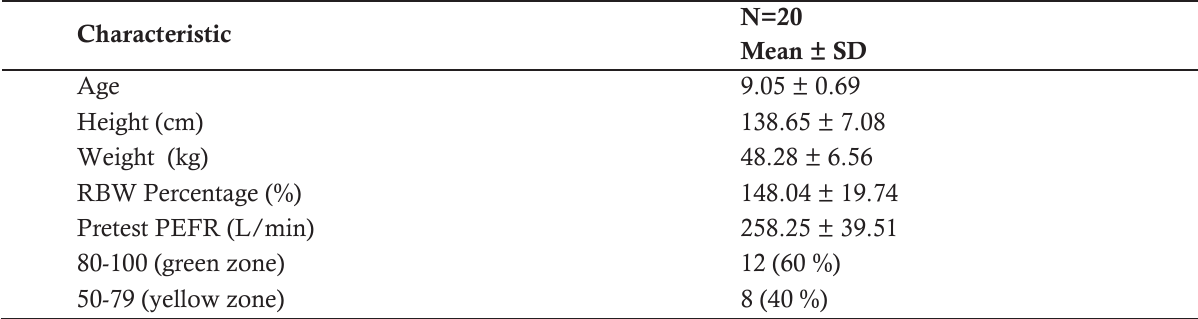
Table 1. Subjects Characteristics